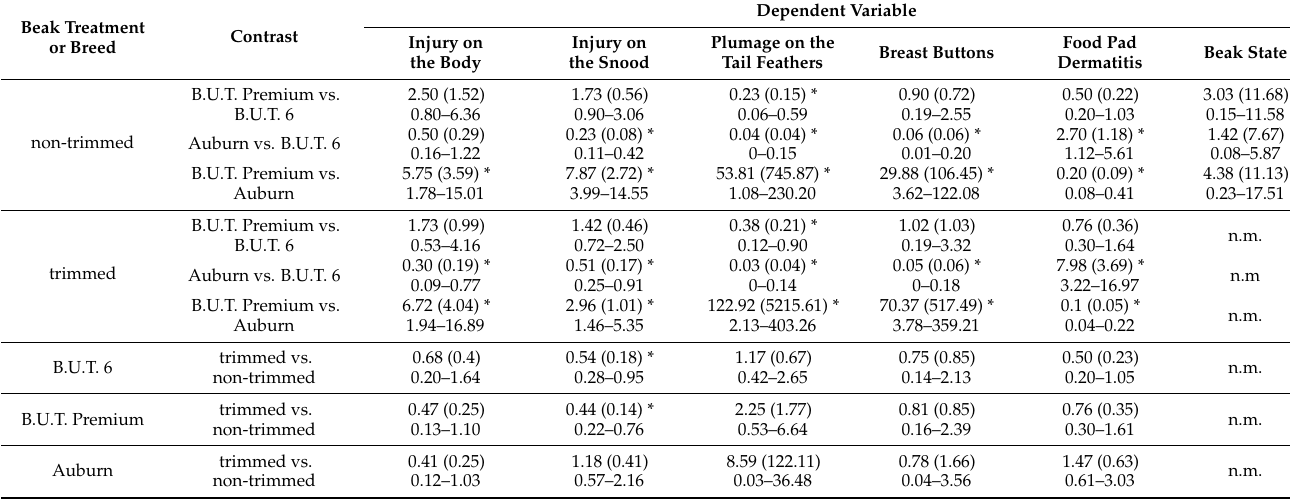
Table 4. Statistical analysis of the examined welfare indicators with the contrasts between the three breeds and the beak- trimmed and non-beak-trimmed turkeys ( n = 192). Shown with the odds ratio, the standard error in brackets and the 95% credible interval below. This analysis was calculated without the variables age, lux (light intensity), and NH 3 (ammonia content). Significant differences are marked with an